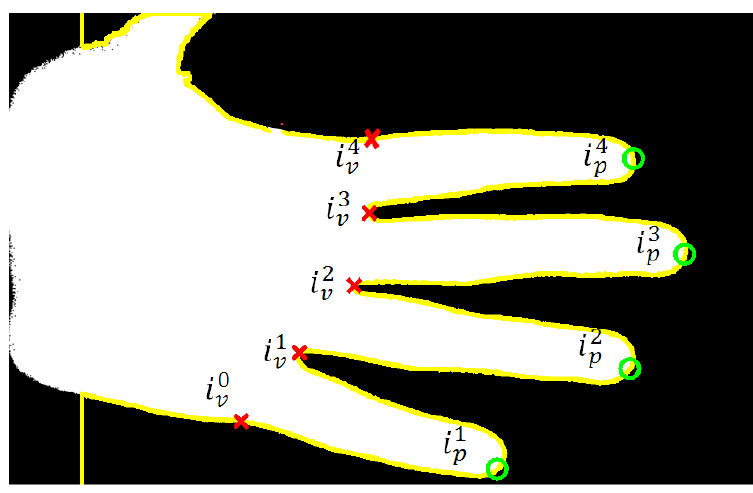
Figure 8. Tips, valleys and exteriors of fingers localization.